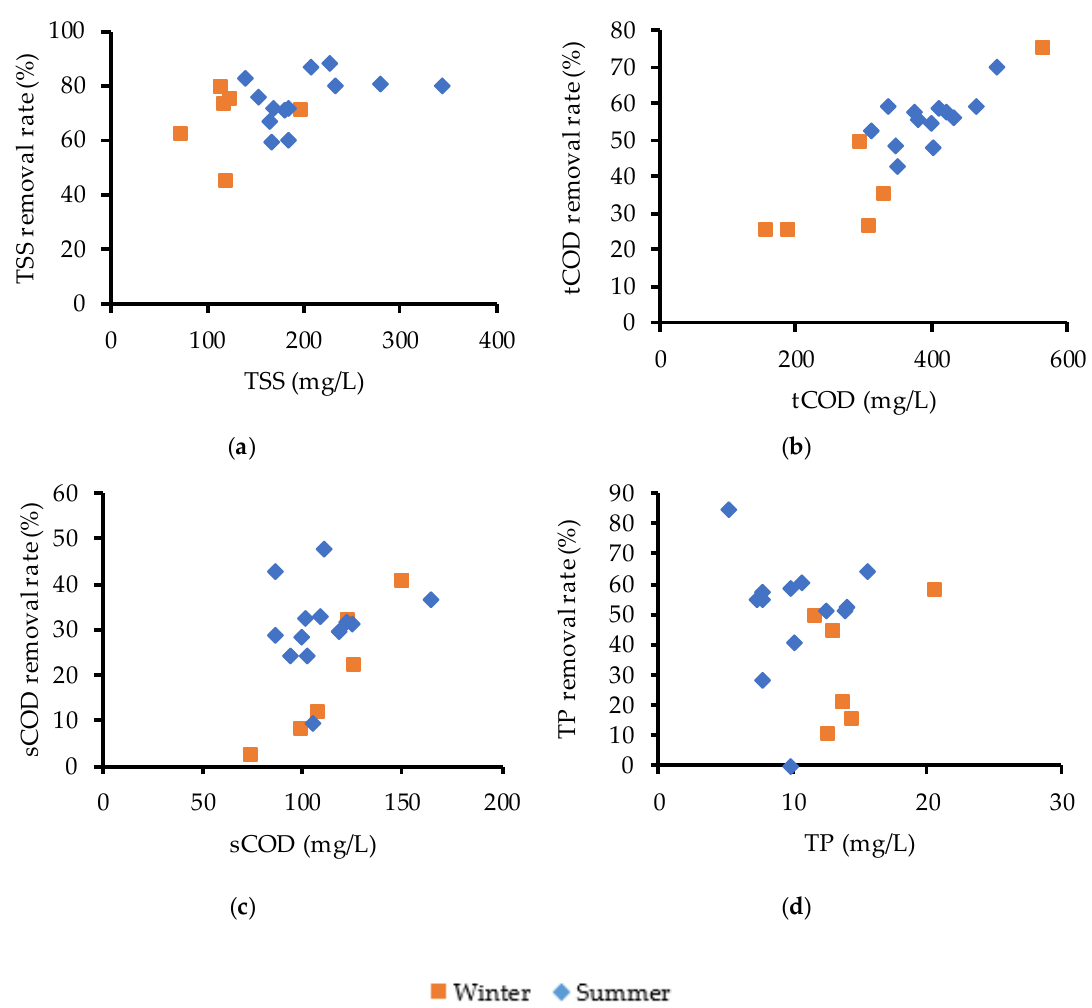
Figure 5. The effect of influent characteristics on removal rate during winter versus summer seasons: ( a ) TSS concentration, ( b ) total COD, ( c ) soluble COD, and ( d ) TP.